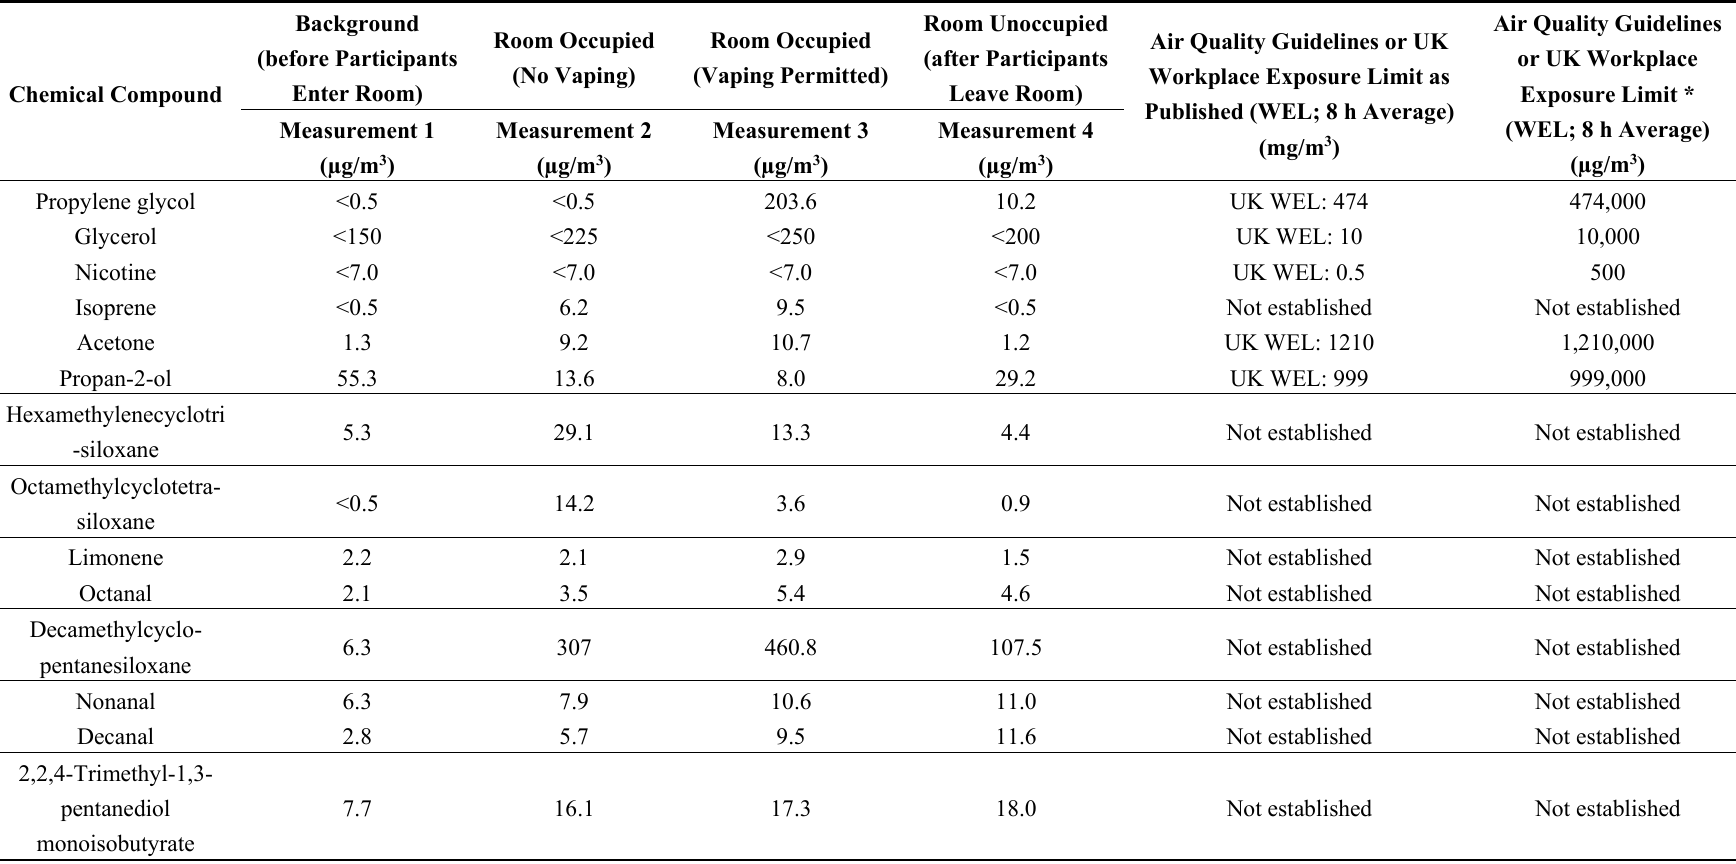
Table 1. Average indoor air concentrations of VOCs (including nicotine, propylene glycol and glycerol (principle components of the e-liquid)) and low molecular weight carbonyls (µg/m 3 ) measured before, during and after use of e-cigarettes from two independent sampling